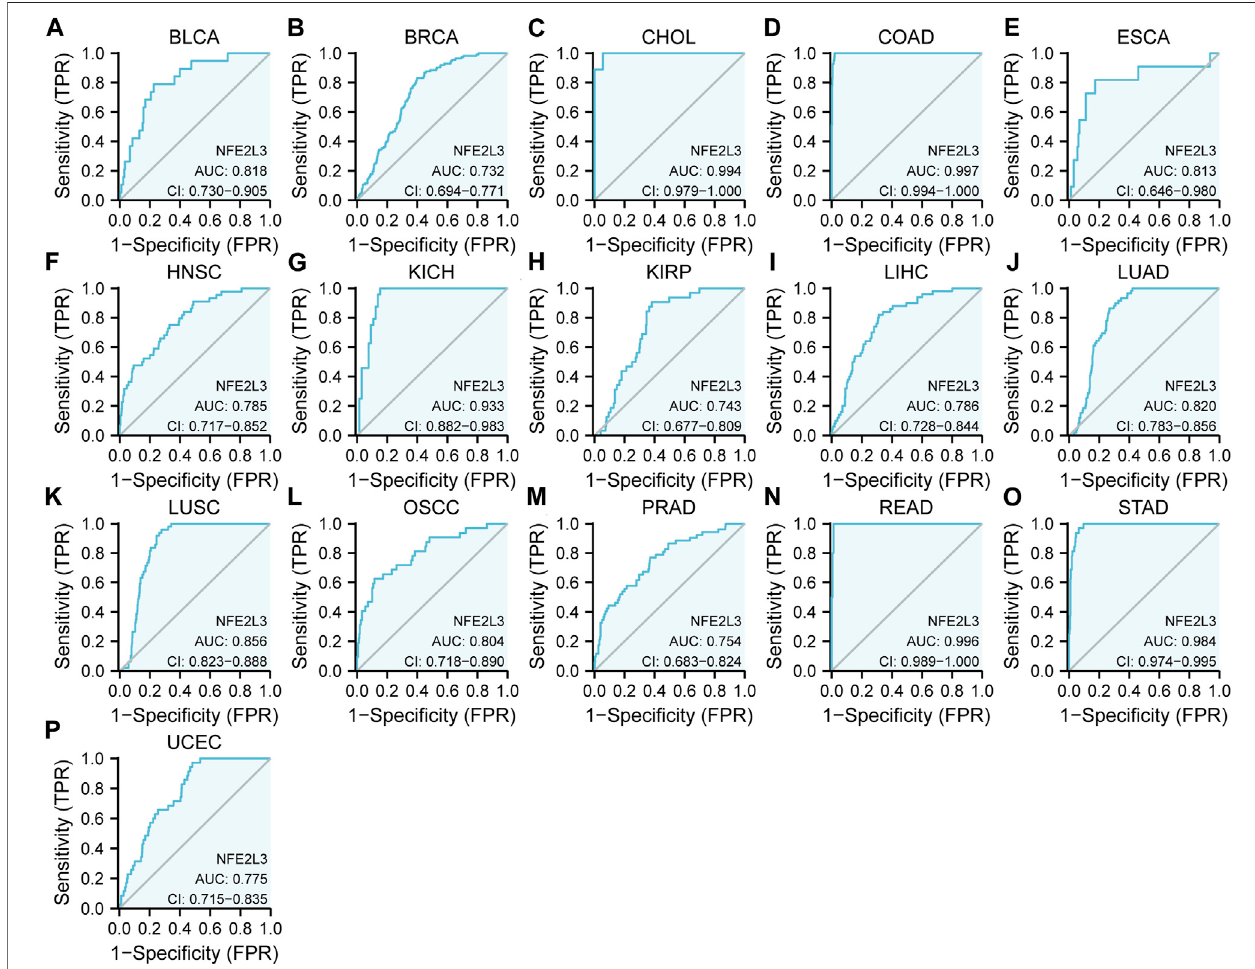
FIGURE 4 | ROC curve of NFE2L3 expression levels in different tumors. (A) BLCA; (B) BRCA; (C) CHOL; (D) COAD; (E) ESCA; (F) HNSC; (G) KICH; (H) KIRP; (I) LIHC; (J) LUAD; (K) LUSC; (L) OSCC; (M) PRAD; (N) READ; (O) STAD; (P) UCEC.